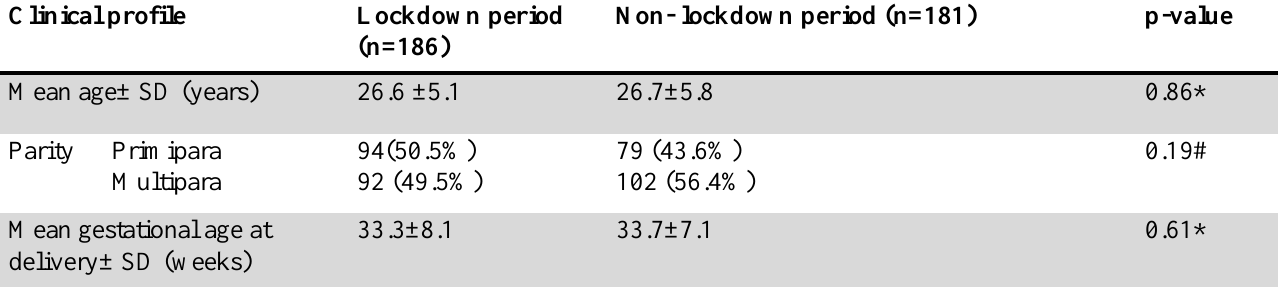
Table 1. Clinical profile of patients with complications in the lockdown and the non-lockdown groups